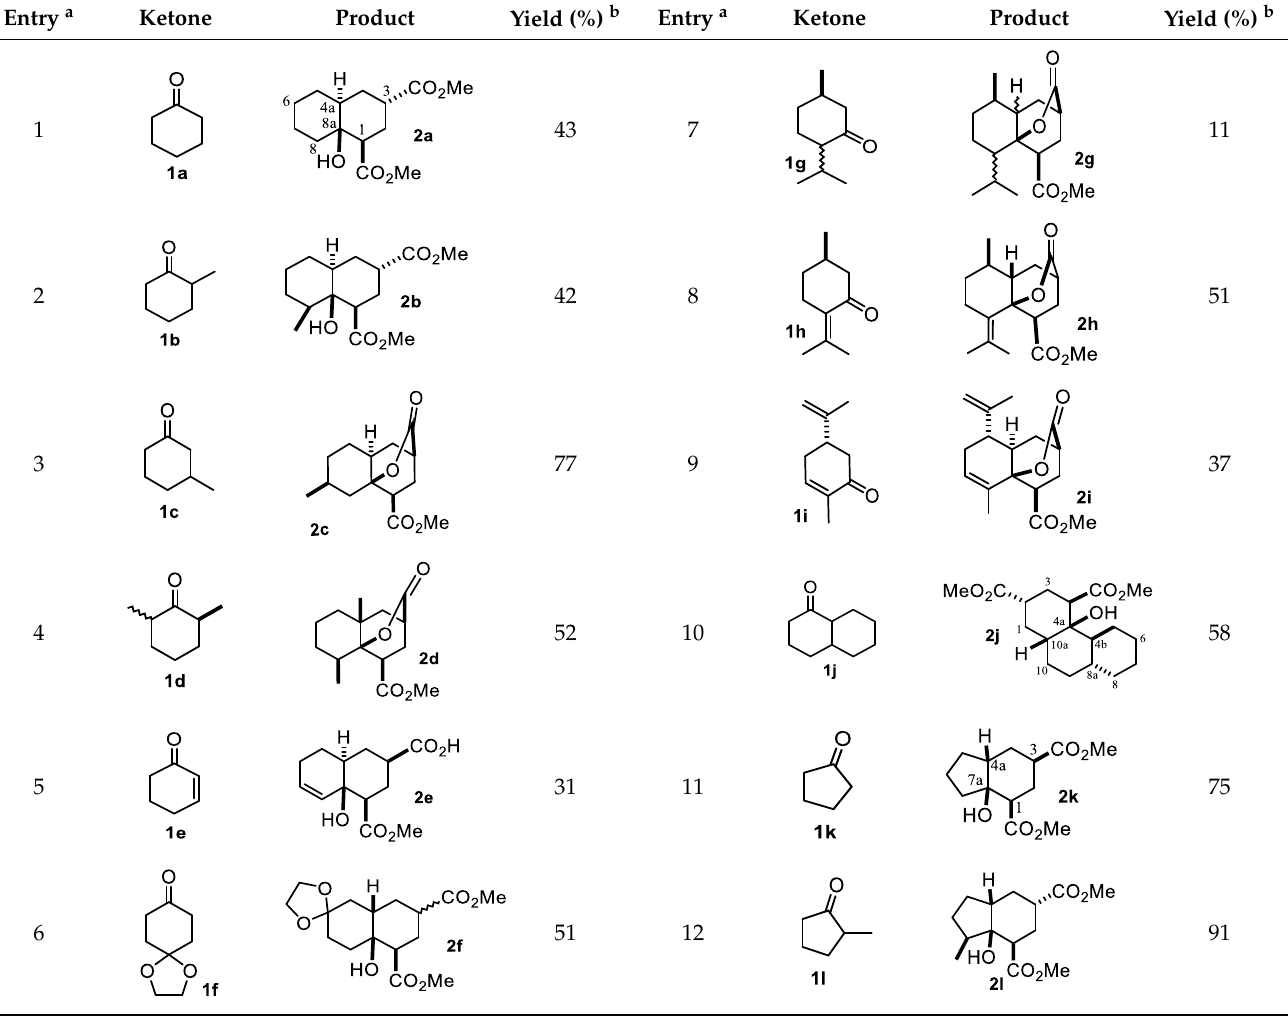
Table 1. Structures of decalin and hydrindane derivatives obtained in higher yields among 8 possible diastereoisomers that could be generated by the MIMIRC reaction between cycloalkanone enolates and methyl acrylate.